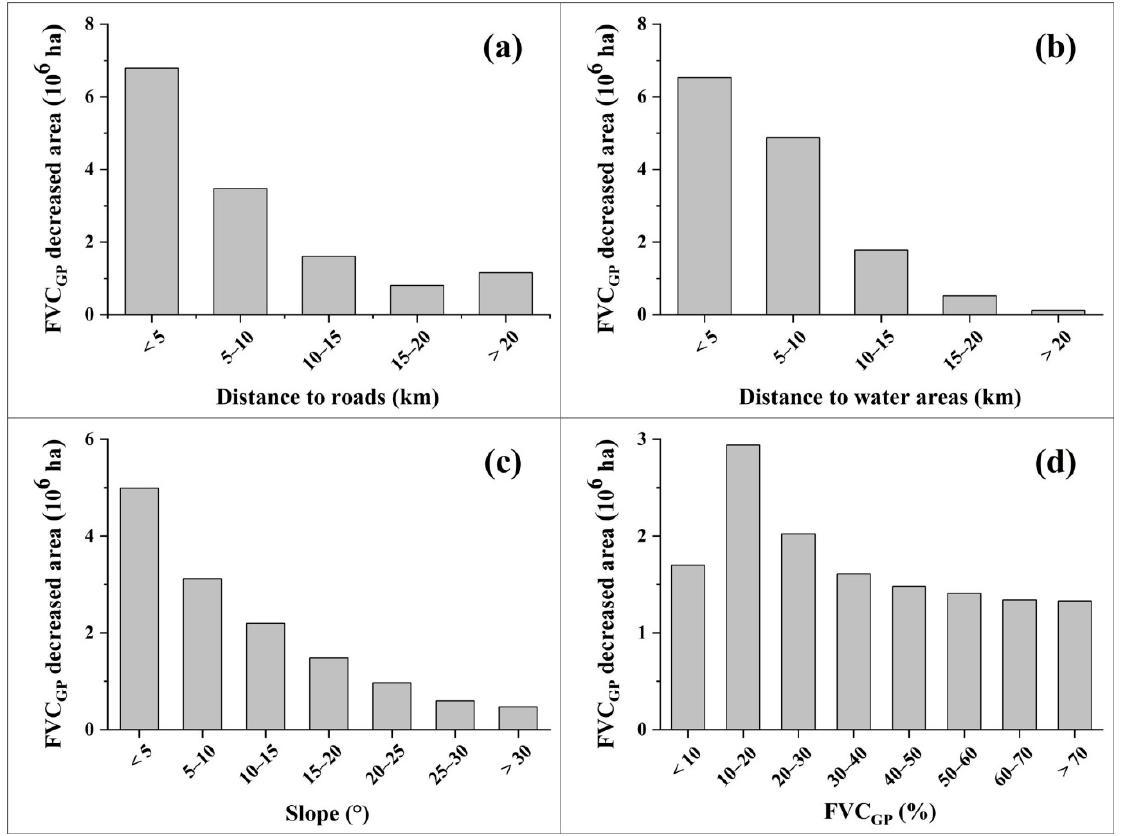
Figure 5. Spatial variations of FVC GP decreased grassland areas in the TP with ( a ) distance to roads, ( b ) distance to water areas, ( c ) slope, and ( d ) FVC GP .